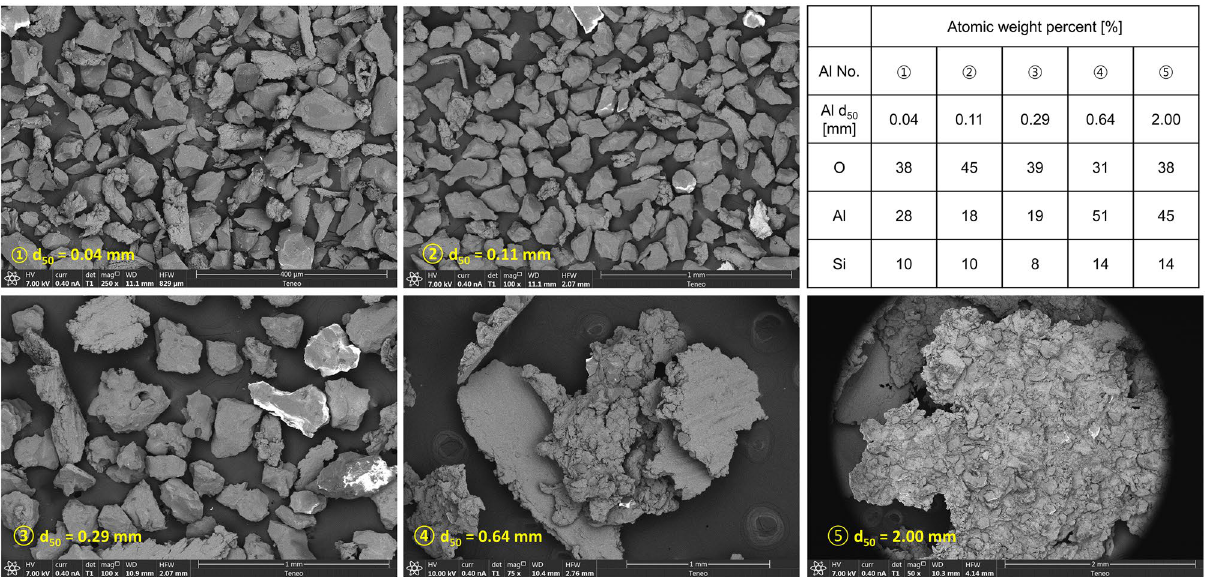
Figure 1. Aluminum chips of different sizes. Scanning electron microscope SEM images. The table summarizes the aluminum content estimated from energy-dispersive X-ray spectroscopy